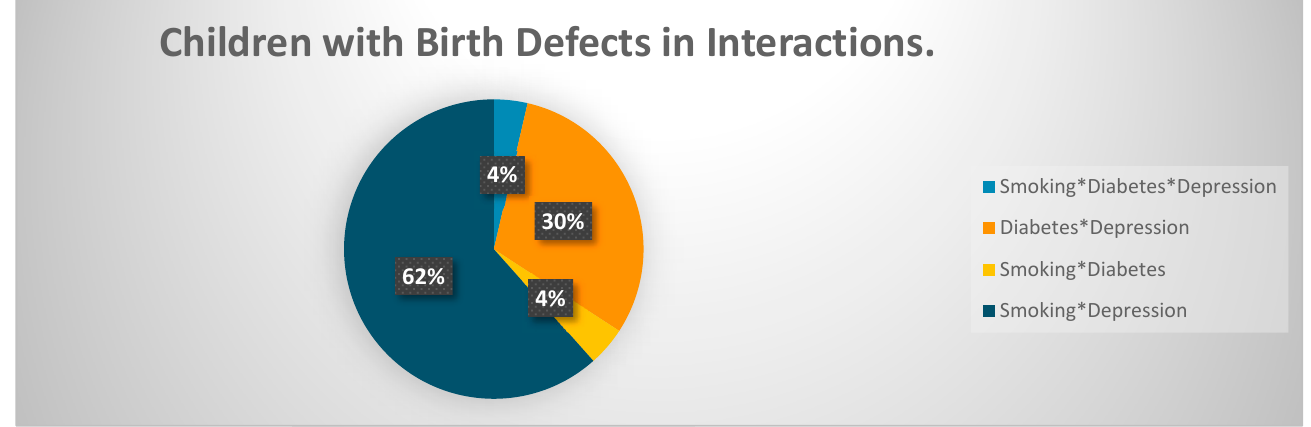
Figure 3. Children with birth defects in interactions. Note: The figure represents children with birth defects when only the interaction of smoking, diabetes, and depression is plotted. * Represent interaction between variables.